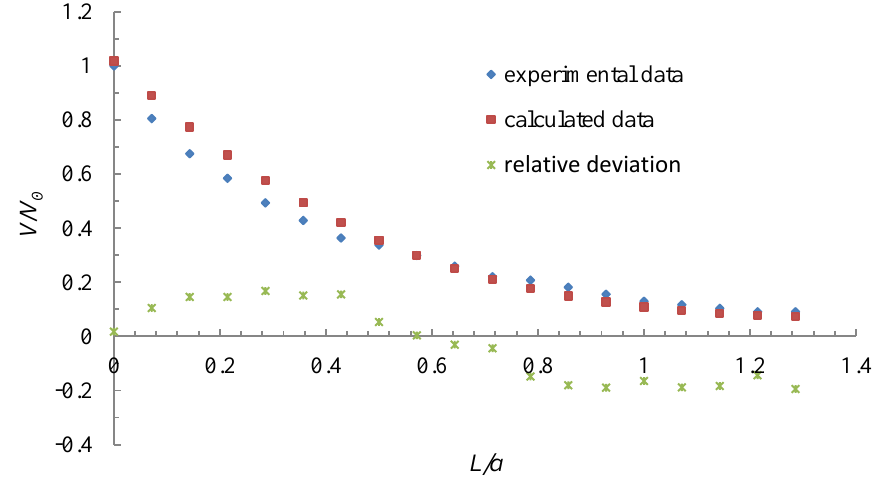
Figure 8. Comparison of experimental and calculated results.